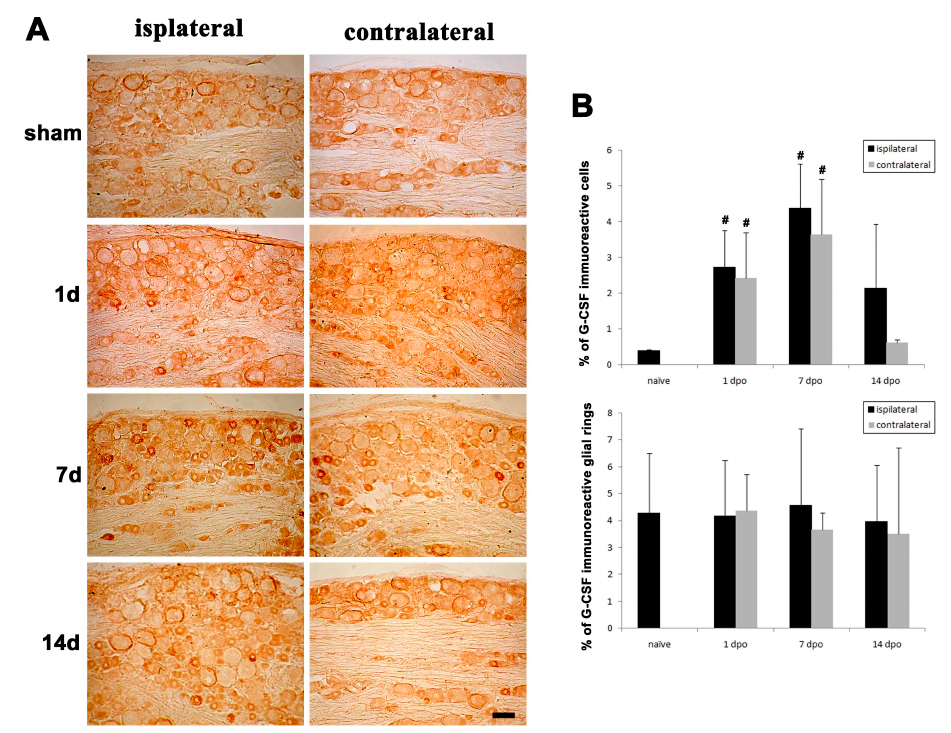
Figure 3. Changes in endogenous G-CSF expression after sciatic nerve injury. ( A ) Rats were sacrificed at 1, 7 and 14 days after PST, and DRG tissues were collected from ipsilateral and contralateral sides and subjected to immunostaining for G-CSF, which was compared between the PST group and the sham group. Bar = 50 µ m. ( B ) Quantification of the number of G-CSF-positive DRG neurons on the ipsilateral and contralateral sides in rats with PST. The data are presented as the mean ± SD, # p < 0.05.